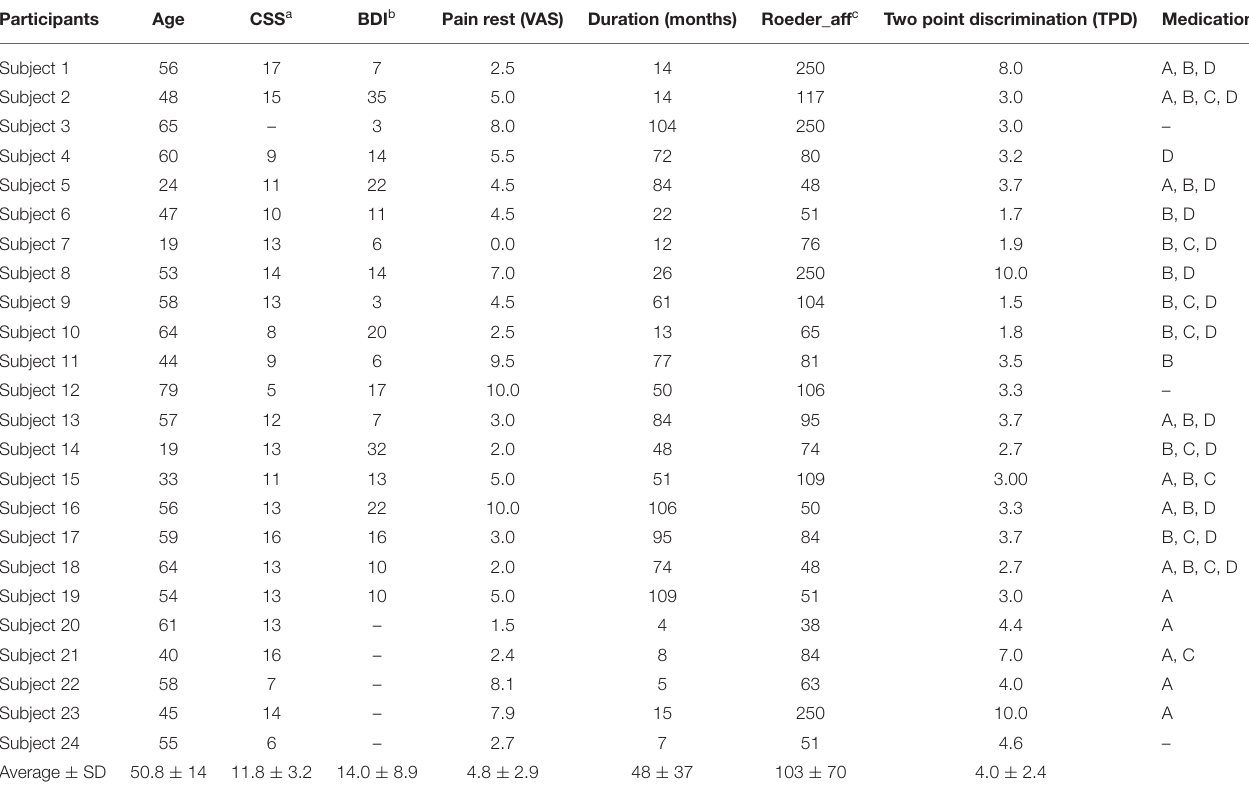
TABLE 1 | Characteristics of CRPS